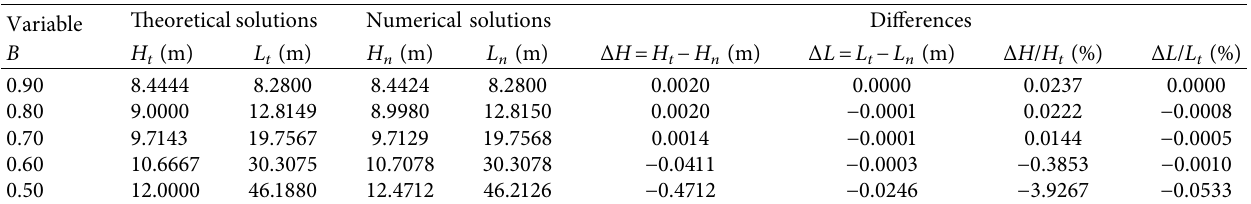
Table 1: Comparison of height H and width L of collapse block between theoretical solutions and numerical solutions with varied parameter B .